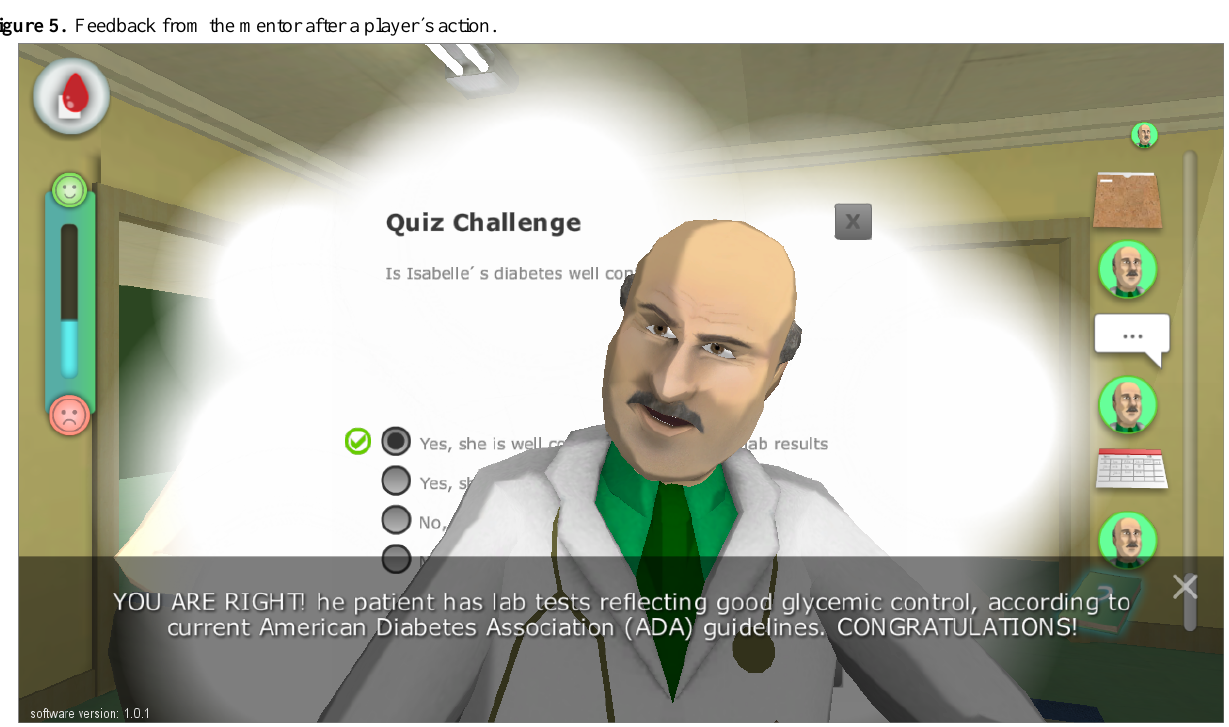
Figure 5. Feedback from the mentor after a player´s